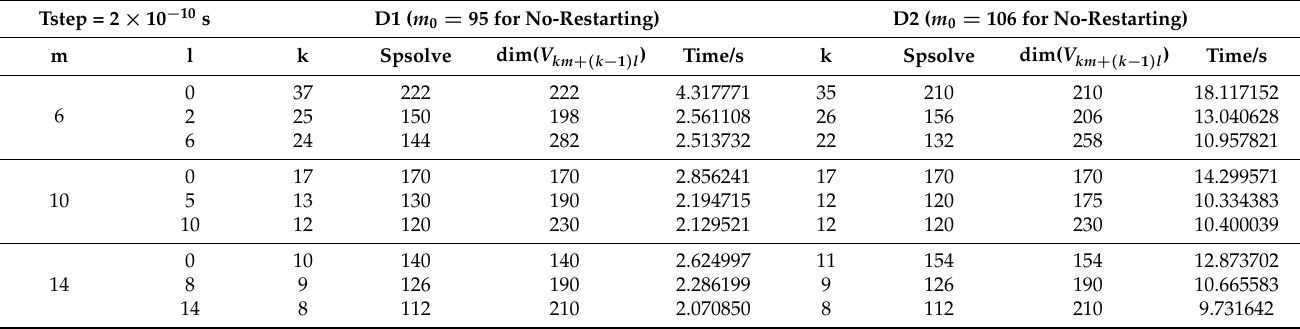
Table 3. Performance data of D1 and D2.